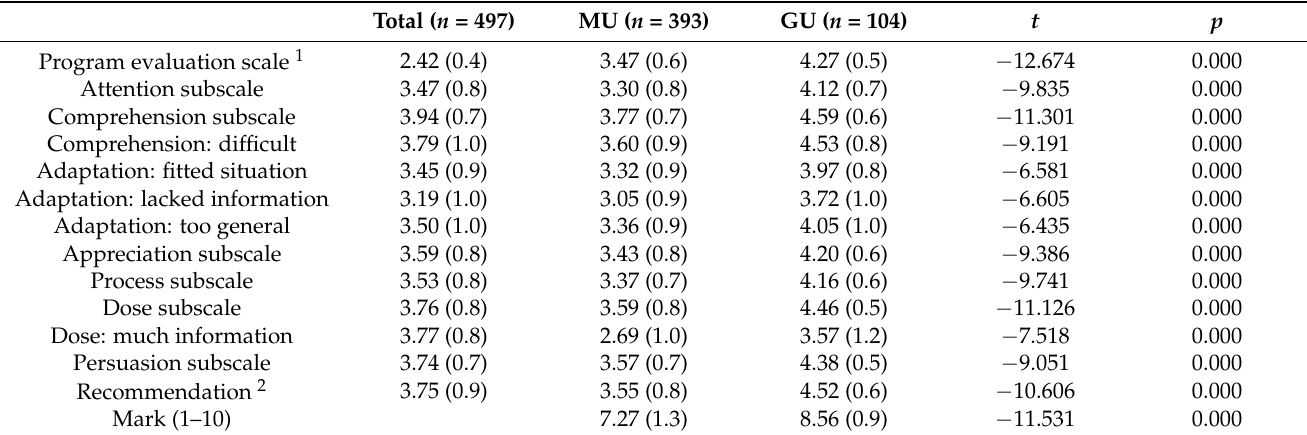
Table 3. Comparison of the mean scores on usability, program evaluation, recommendation to others and grading mark of MU and GU smokers.